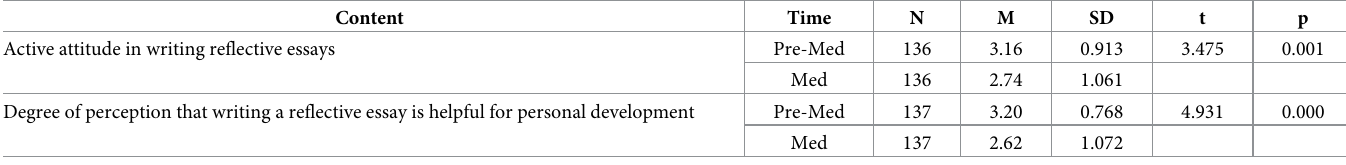
Table 4. Changes in attitudes and perception regarding reflective